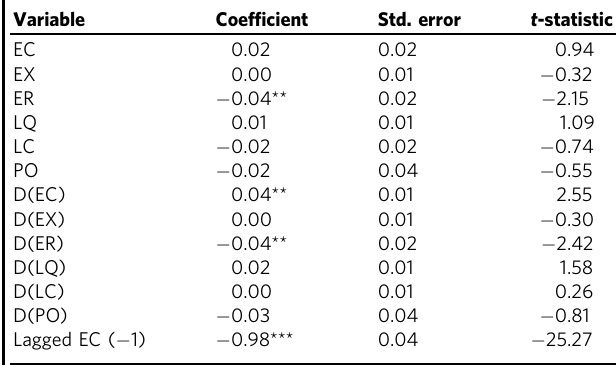
Table 7 Panel co-integration test